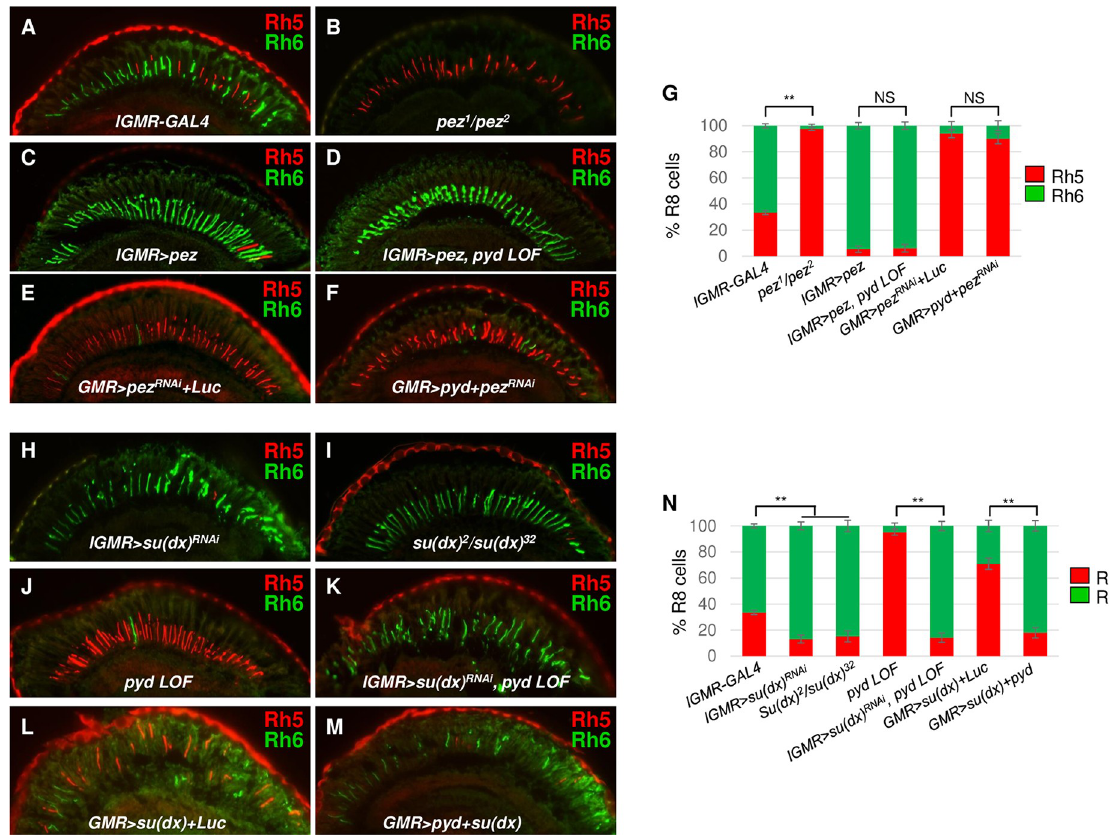
expense of Rh5-expressing pR8s (13.2 ± 3.1%) ( Fig 6H and 6N ). We additionally used su(dx) mutations su(dx) 2 and su(dx) 32 to generate heteroallelic su(dx) 2 / su(dx) 32 mutant flies and ana- lyzed R8 subtypes in these flies. su(dx) 2 / su(dx) 32 retinas showed a similar R8 subtype